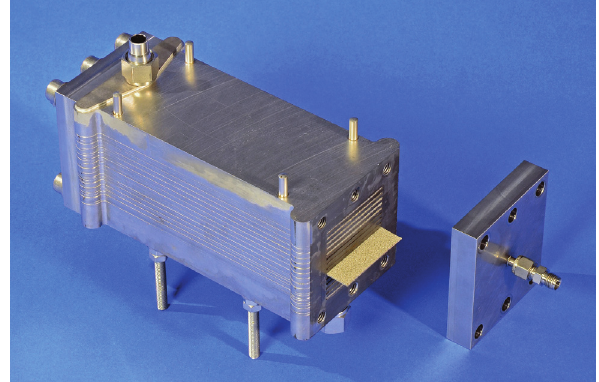
Figure 5 Vacuum brazed foam reactor for high pressure and temperature applications.